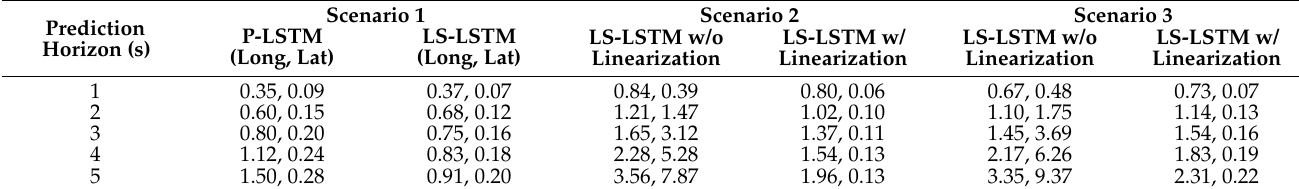
Table 3. Longitudinal and lateral RMSEs in meters with simulation